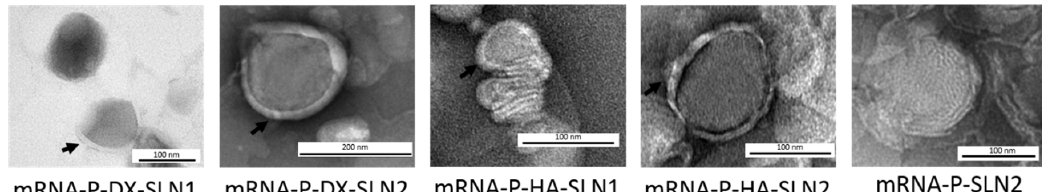
Figure 1. Images of mRNA combined with P, a polysaccharide (DX or HA) and SLN1 or SLN2, acquired by TEM. Black arrows indicate an external layer surrounding the electro-dense nucleus of the vectors.